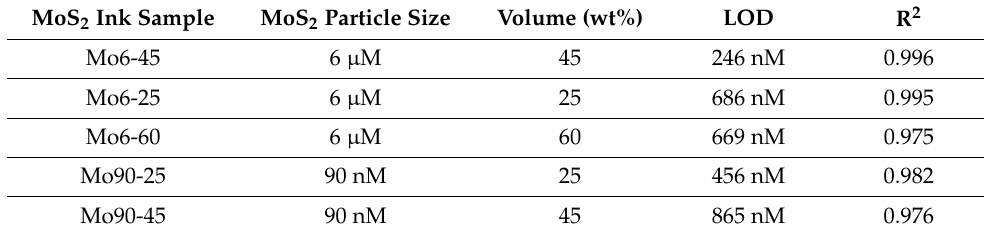
Table 1. Table 1. Performance of MoS 2 ink towards dopamine sensing in the work of Pavliˇckov á et al. [102]. MoS 2 Ink